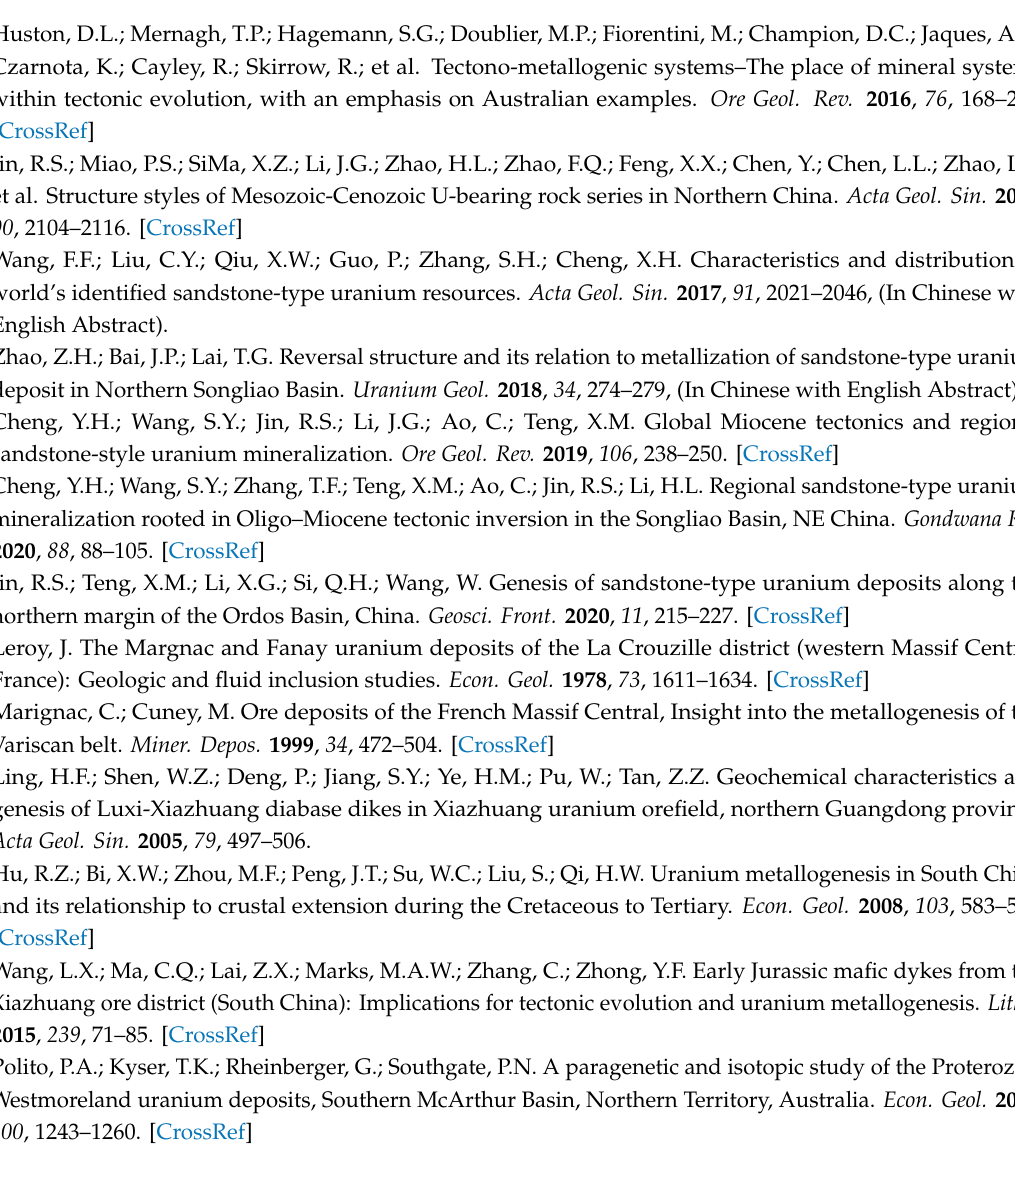
Table S1 . Zircon U–Pb isotopic data from the mafic rocks in the Qianjiadian U deposit, NE China. Table S2